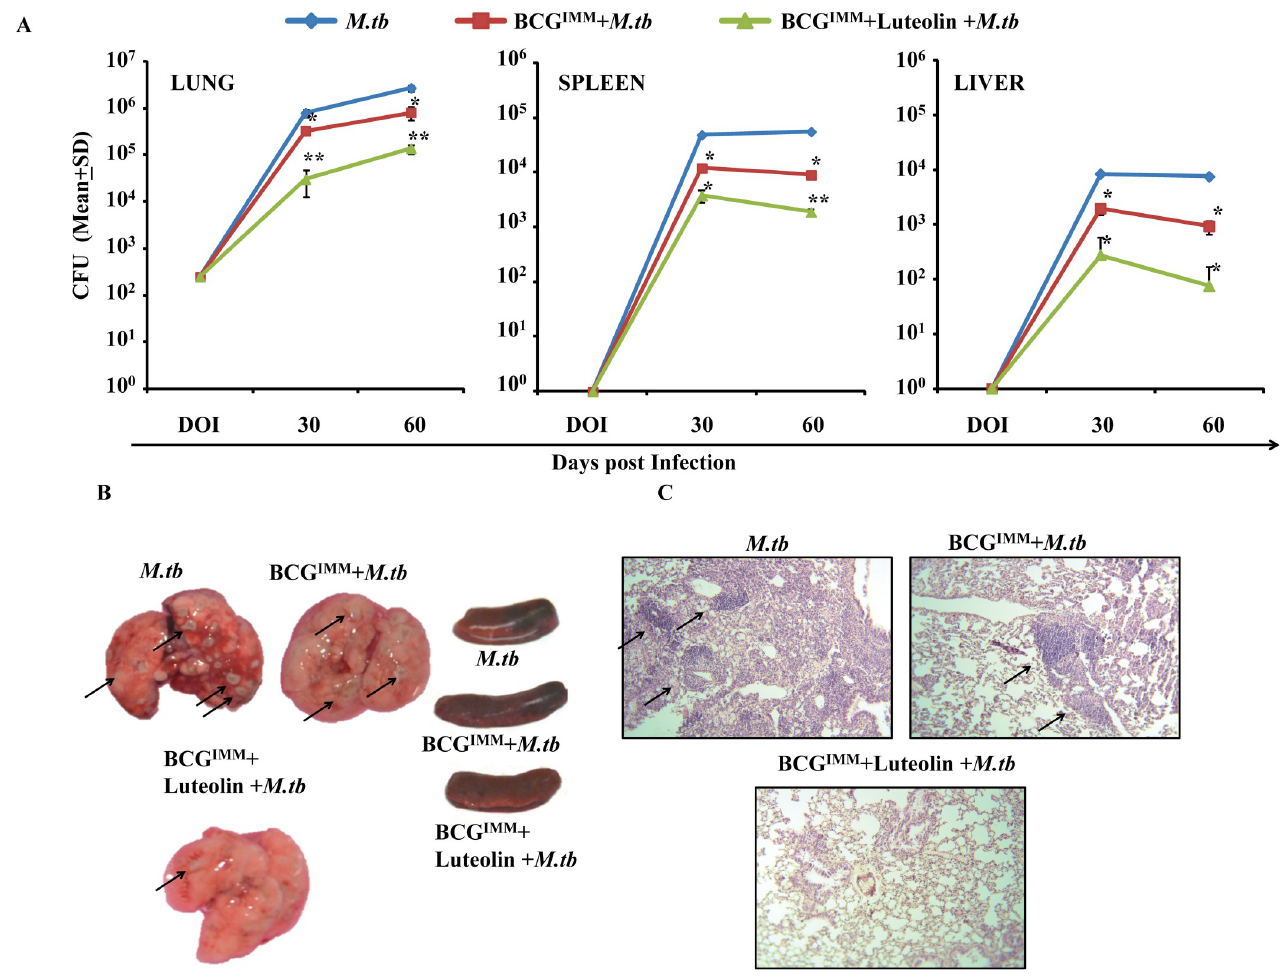
Fig 6. Luteolin treatment of BCG-immunized mice confers improved protection against TB. Mice immunized with BCG were treated with 5 mg/kg of luteolin or vehicle for 20 days and rested for an additional 30 days. These immunized mice and a control group of non-immunized mice were then infected with M.tb. Three randomly selected mice from various groups were euthanized at the indicated time points and lung, liver and spleen were harvested and homogenised. (A) CFUs from the lung, spleen and liver homogenates of M.tb infected mice. (B) Gross pathology of lungs and spleen at different time points after M.tb infection. Arrows indicate granulomatous lesions. (C) Lungs were dissected out and preserved in 10% neutral buffered Formalin (10% NBF). These preserved lungs were then processed for paraffin embedding, sectioning and staining with Hematoxylin and Eosin (H&E). Arrows indicate granulomatous lesions. Data represented as the mean ± STDEV values from data pooled from three experiments with five mice per experiment. Differences were considered significant at P < 0.05 using one way ANOVA. � p < 0.05, �� p < 0.005, ��� p < 0.0005.